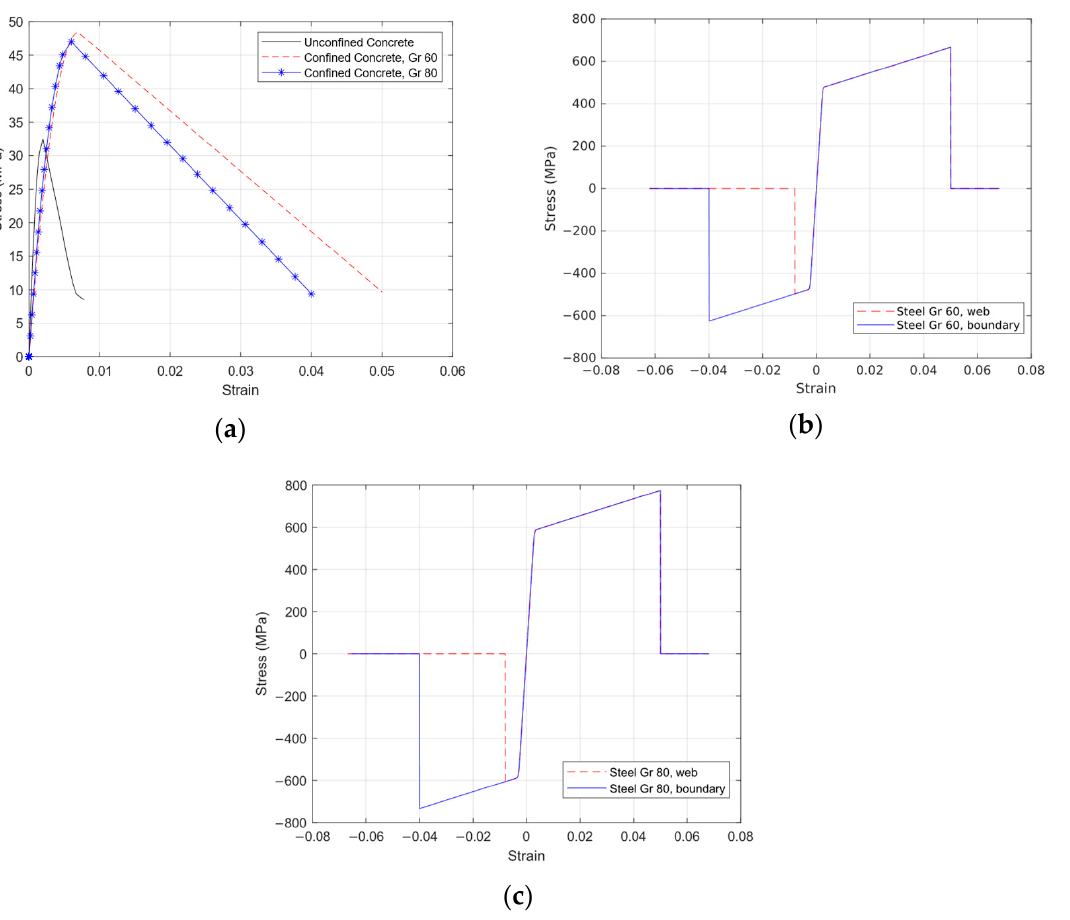
Figure 4. Constitutive laws in M1 walls: ( a ) concrete under compression; ( b ) Gr 60 steel; ( c ) Grade 80 steel.